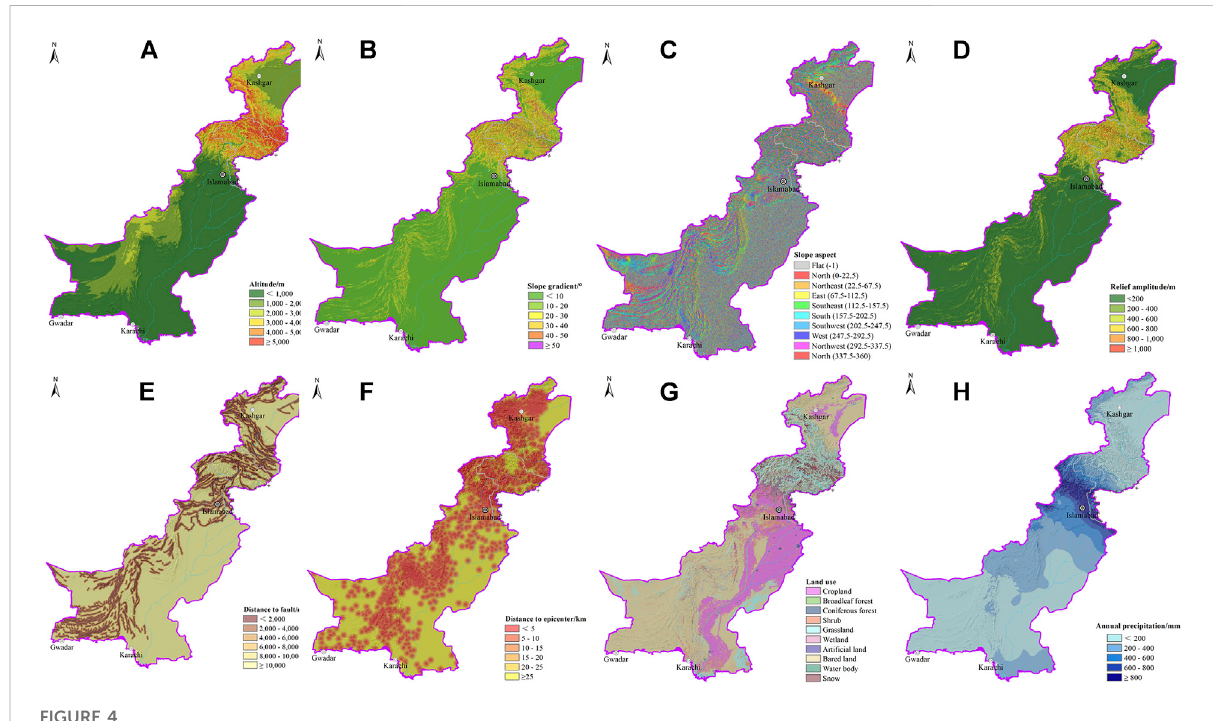
FIGURE 4 Landslide hazard assessment factors of CPEC [ (A) altitude; (B) slope gradient; (C) slope aspect; (D) relief amplitude; (E) distance to fault; (F) distance to epicenter; (G) land use; and (H) annual